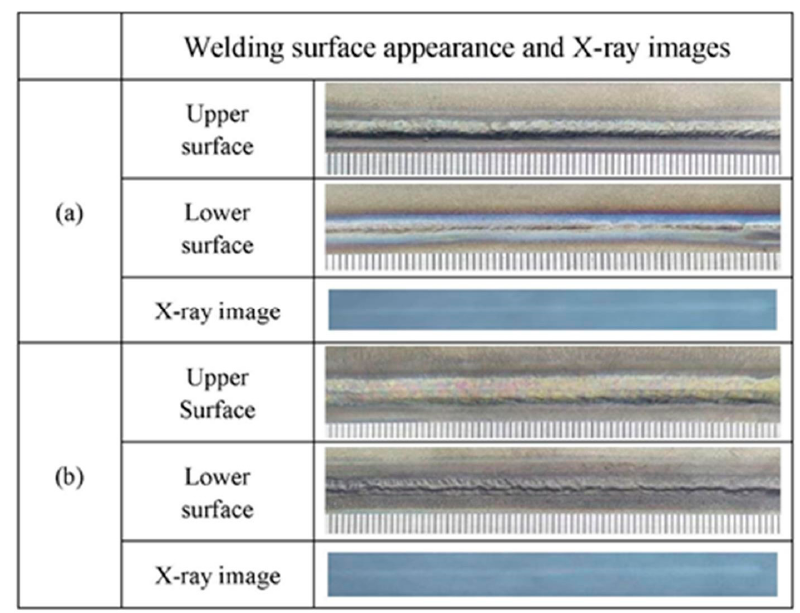
Figure 14. The welding surface appearance and X-ray images; ( a ) the underwater weld metal; ( b ) the in-air weld metal.